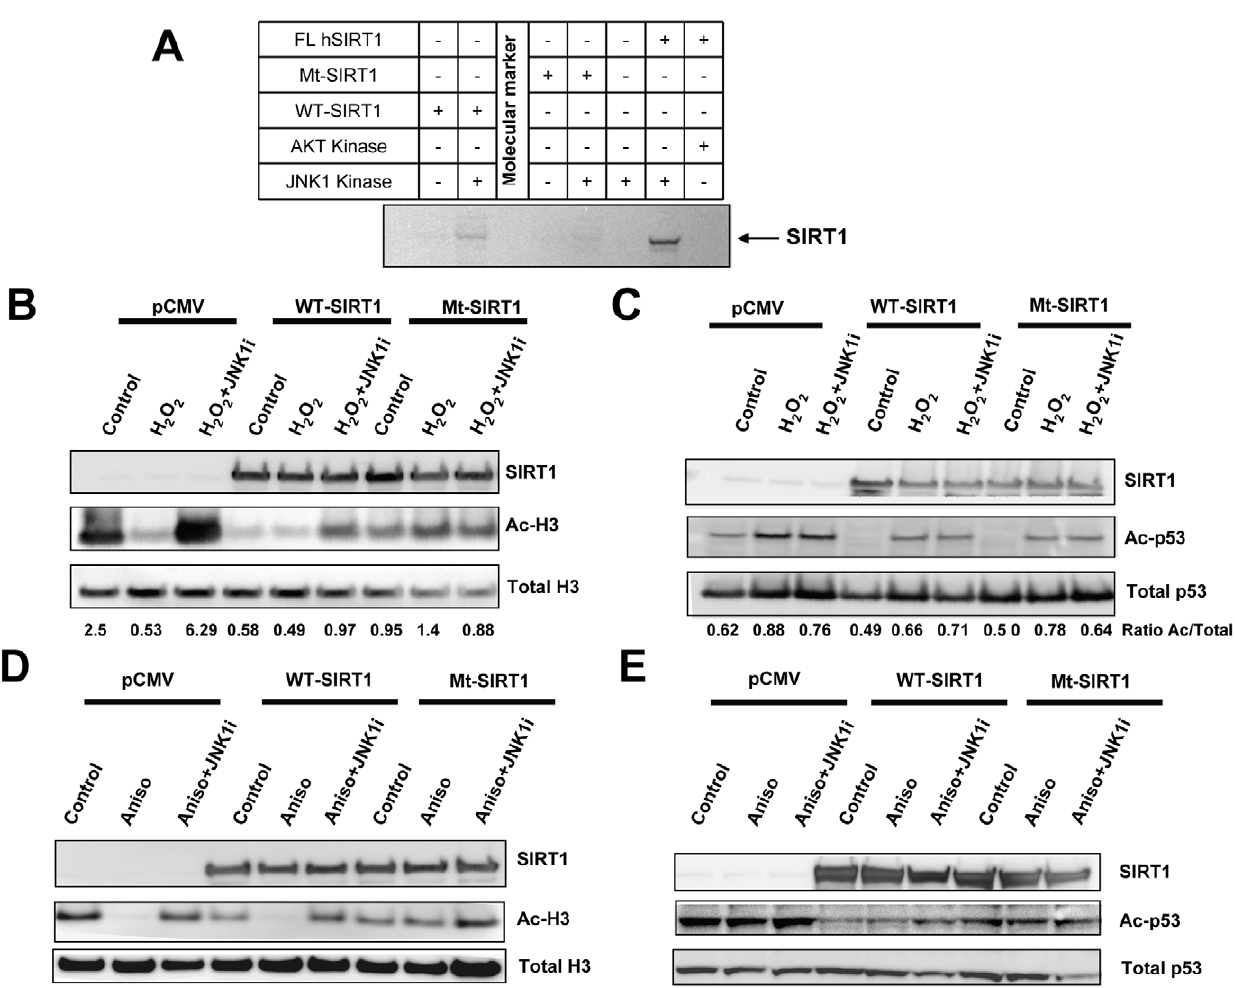
Figure 6. Mutation of putative JNK phosphorylation sites on hSIRT1 reduces phosphorylation and activity of SIRT1. A , In vitro phosphorylation of full length (FL) hSIRT1 or SIRT1 with the putative JNK phosphorylation sites mutated (Mt-SIRT1). FL hSIRT1 or Mt-SIRT1 was incubated with recombinant JNK1. B , Mt-SIRT1 shows decreased activity in deacetylation of histone H3. Cells were transfected with the empty vector (CMV), WT hSIRT1 (WT) or Mt-SIRT1 (Mt) then treated with H 2 O 2 or H 2 O 2 plus JNK inhibitor (JNKi). SIRT1, acetylated histone H3 (Ac-H3) or total histone H3 were examined by Western blotting. C , Mt-SIRT1 shows similar activity to WT SIRT1 in deacetylation of p53. Experiment performed as in B , except that acetylated p53 (Ac-p53) and total p53 levels were monitored. The ratio Ac/Total shows the quantification of the expression levels of the acetylated substrates vs . the total levels of the same substrates. D , Mt-SIRT1 shows decreased activity in deacetylation of histone3 (H3). Cells were transfected with the empty vector (CMV), WT hSIRT1 (WT) or Mt-SIRT1 (Mt) then treated with anisomycin or anisomycin plus JNK inhibitor (JNKi). SIRT1, acetylated histone H3 or total H3 were examined by Western blotting. E , Mt-SIRT1 shows similar activity to WT SIRT1 in deacetylation of p53 when cells were treated with anisomycin. The experiment was performed as in D , and the levels of acetylated p53 (Ac-p53) and total p53